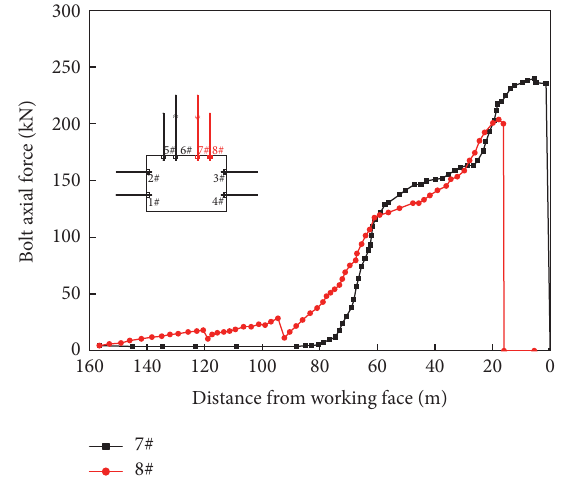
Figure 22: Nonhydraulic fracturing section: stress of the anchor cable at 5# station.